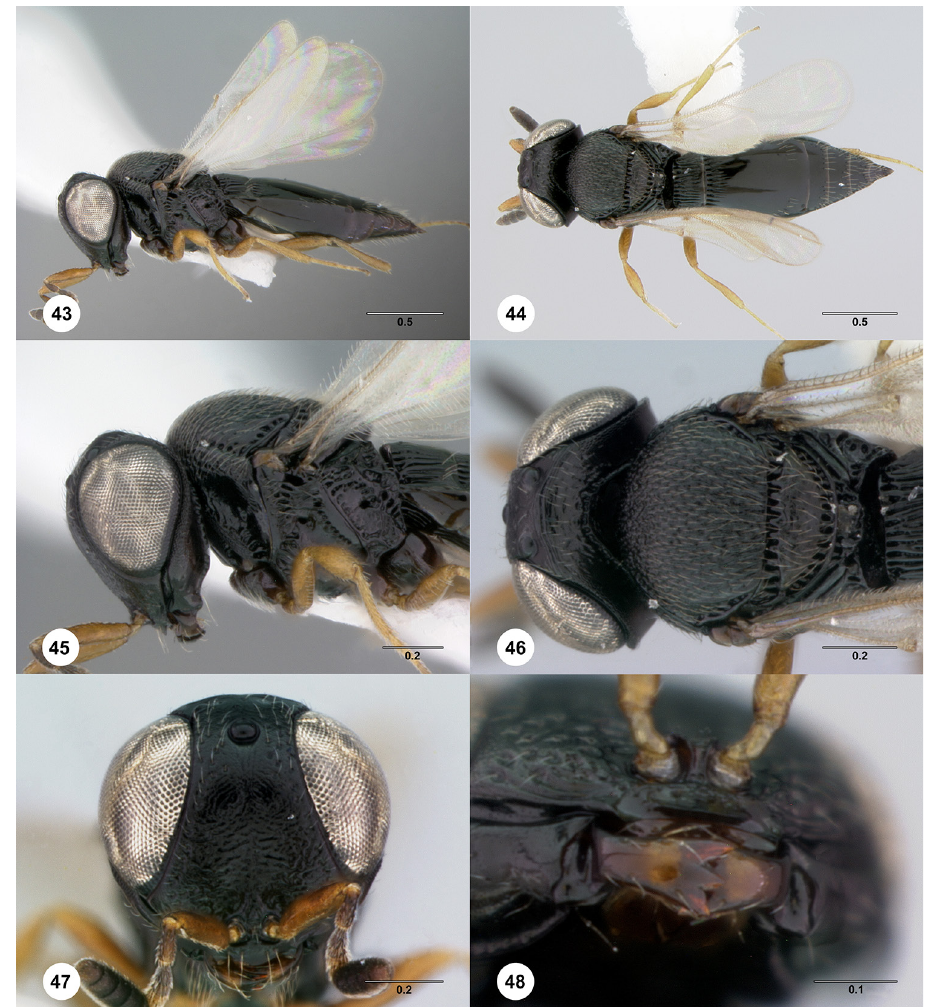
Figures 43–48. Phanuromyia galerita ♀ (OSUC 550202), 43 Lateral habitus 44 Dorsal habitus 45 Head, mesosoma, lateral view 46 Head, mesosoma, dorsal view 47 Head, mouthparts, anteroventral view 48 Mouthparts, ventral view. Scale bar in millimeters. Sculpture on posterior half of mesoscutum: with strong, parallel longitudinal keels. Sculpture of anterior half of mesoscutellum: rugose-punctate. Thin median foliaceous lamella on propodeum: absent. Color of coxae: dark brown to black, contrasting with legs. T1: flat, at most slightly swollen. Anterior margin of T2: with costae or foveolae throughout its width. T2 sculpture: with neither transverse series of small punctures nor scrobiculate lateral areas. Sculpture of T1: entirely costate. Posterior margin of T2: straight; slightly convex. Number of visible terga past T2: 5. Setation on T2: limited to at most 1 row of setae posteriorly and sparse setation